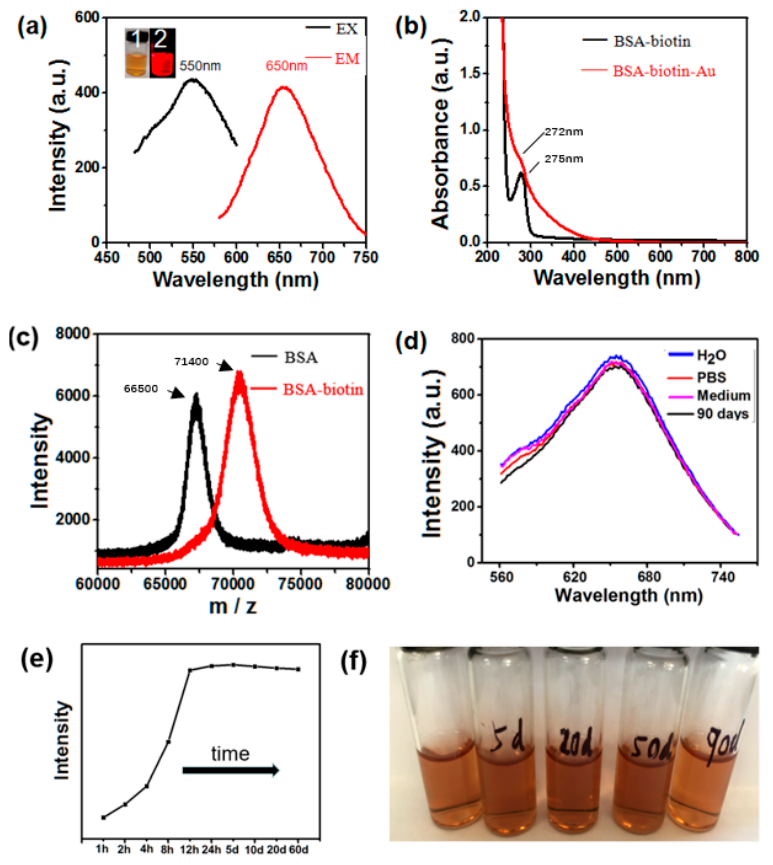
Figure 1. ( a ) The fluorescence excitation (black line, λ ex = 550 nm), and emission (red line, λ em = 650 nm) spectra of the red-emitting BSA-biotin-Au. Digital photos of BSA-biotin-Au under (1) visible and (2) 365 nm portable UV light. ( b ) The UV-vis absorption of BSA-biotin (black line) and BSA-biotin-Au (red line). ( c ) The MALDI-TOF-MS spectra of BSA (66,500 KDa) and BSA-biotin (71,400 KDa). ( d ) The fluorescence intensity of BSA-biotin-Au in different solvents. ( e ) Time-dependent fluorescence intensity curve of BSA-biotin-Au. ( f ) Color change of BSA-biotin-Au aqueous solution at room temperature with different time.